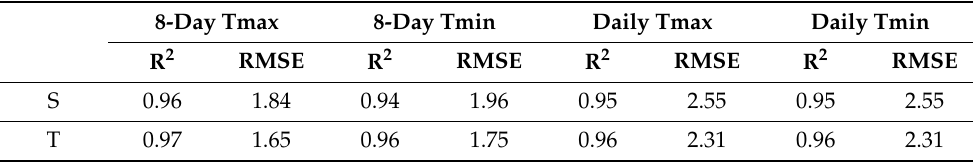
Figure 4. Estimation accuracy, i.e., R 2 and RMSE, of 8-day ( a , c ) and daily ( b , d ) Tmax and Tmin in both spatial and temporal experiments on a climate zone scale. Table 2. Estimation accuracy of 8-day and daily Tmax and Tmin in both spatial and temporal experiments on a global